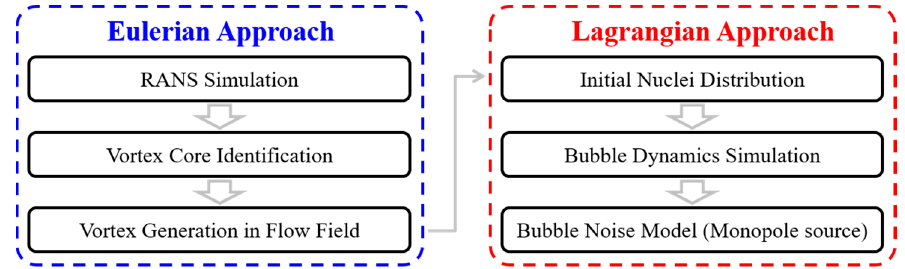
Figure 1. Numerical procedure using the sequential one-way coupled application of Eulerian and Lagrangian methods.